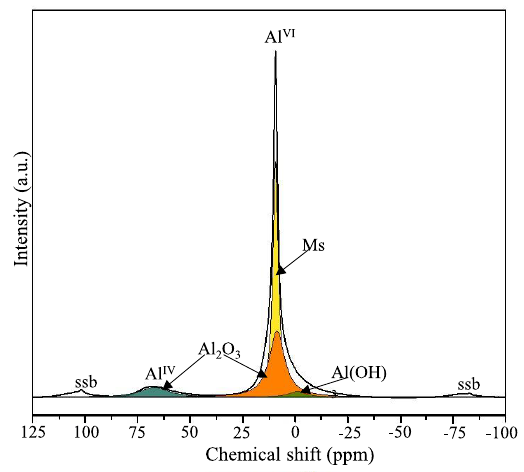
Figure 5. 27 Al NMR spectrum of the sample after hydrothermal synthesis.